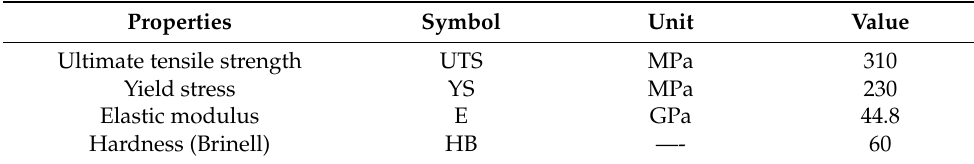
Table 6. Mechanical properties of AZ61 magnesium alloy [76].